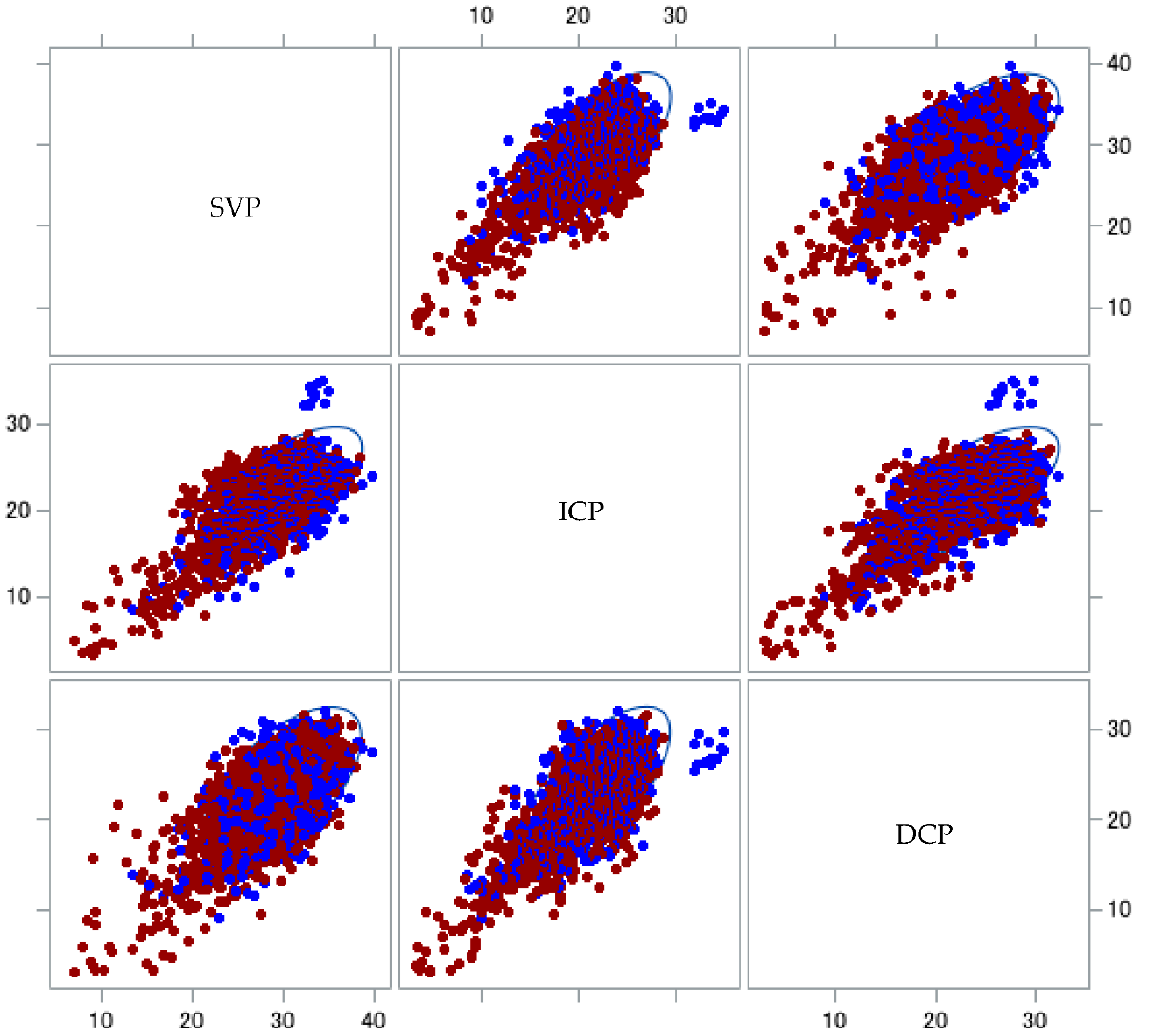
Figure 2. Scatter plot of vessel density differences in patients with post-COVID-19 syndrome (PCS) in relation to gender: matrix showing the relationship between vessel densities in the SVPs, ICPs and DCPs of patients with PCS. Each set of vessel density data is color-coded according to gender (male, blue; female, red), with 95% prediction ellipses. Female patients with PCS and CF showed lower VDs. SVP—superficial vascular layer, ICP—intermediate capillary plexus, DCP—deep capillary plexus.